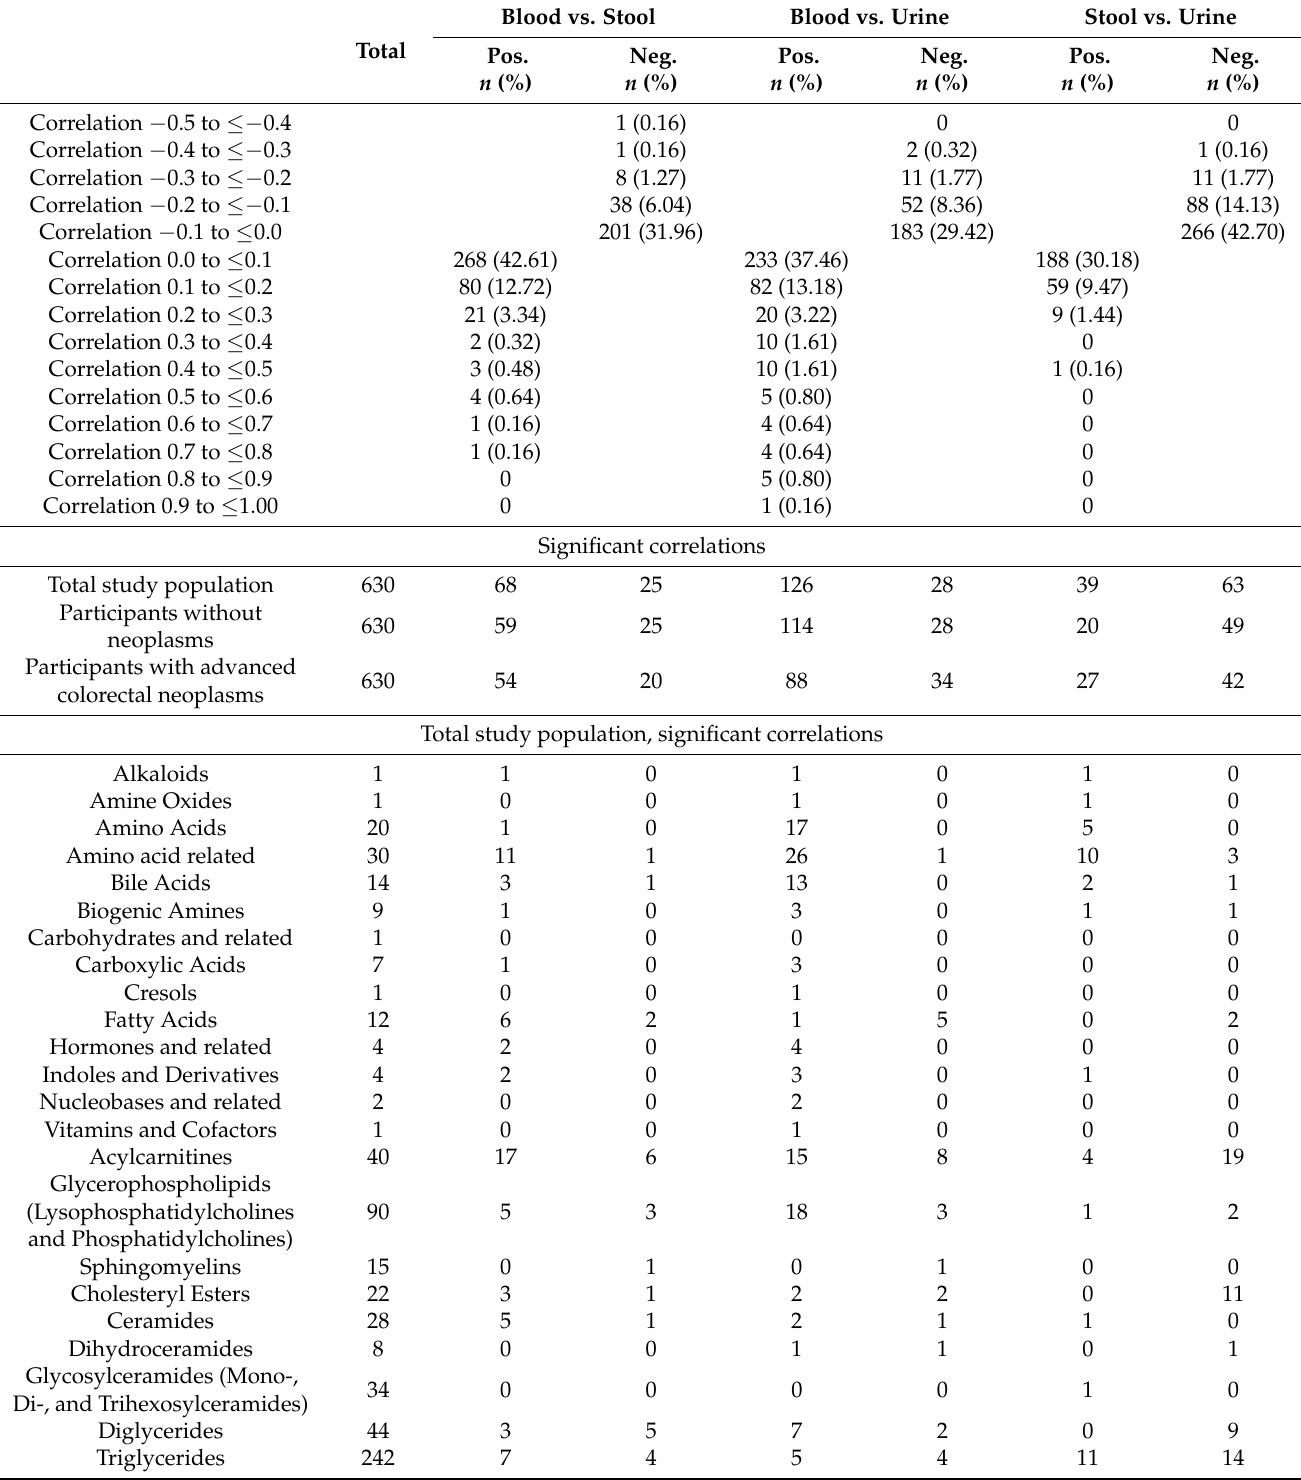
Table 2. Spearman Correlation Coefficients between metabolites in different bio-fluids. Blood vs. Stool Blood vs. Urine Stool vs. Total